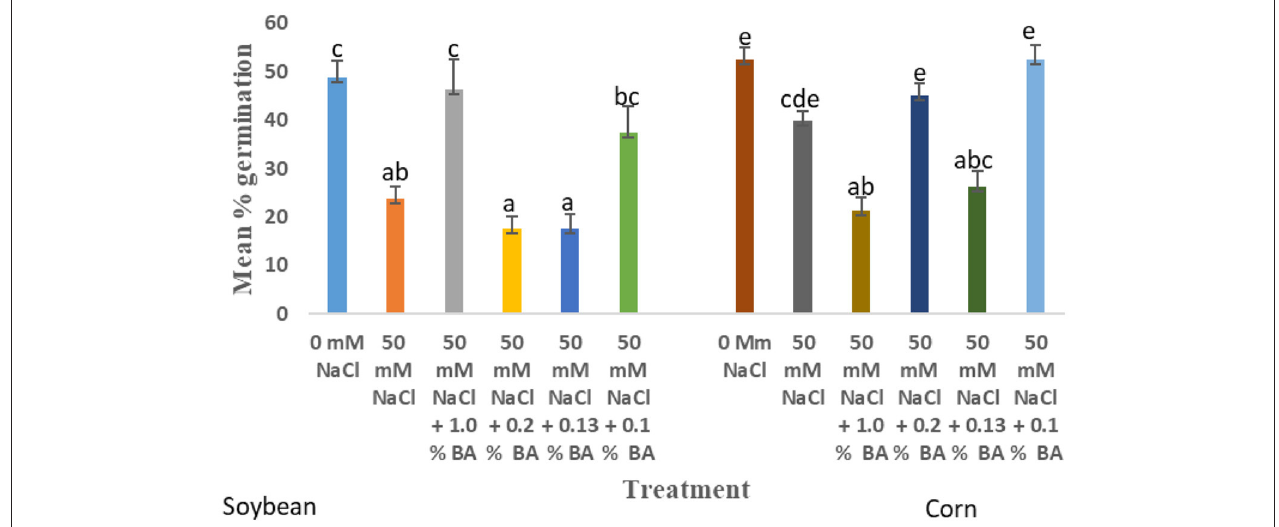
FIGURE 4 | Effect of BA cell-free supernatant on mean percentage germination of corn and soybean exposed to 50mM NaCl for 24h. Treatments with similar letters are not significantly different. Treatments with different letters are significantly different.